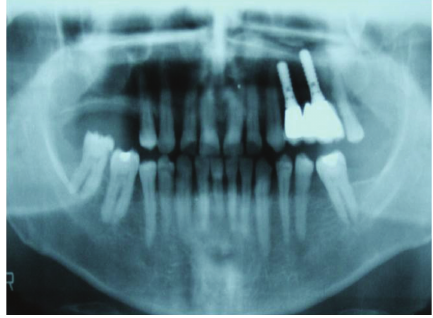
Figure 5: Radiological view after prosthetic rehabilitation.